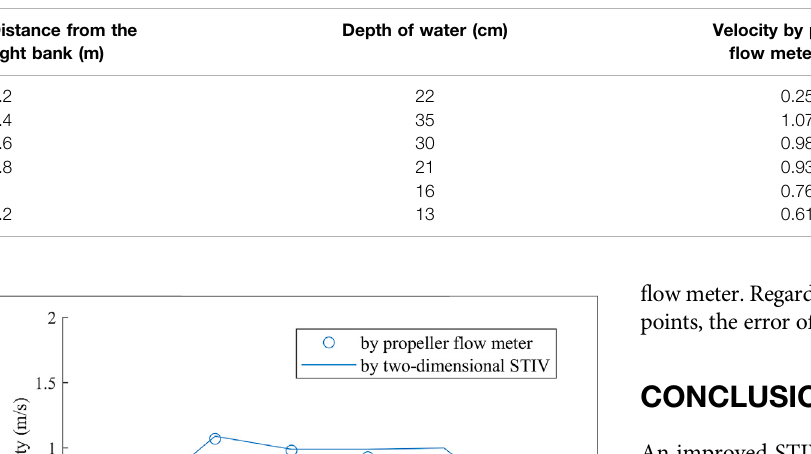
fl ow meter (m/s)